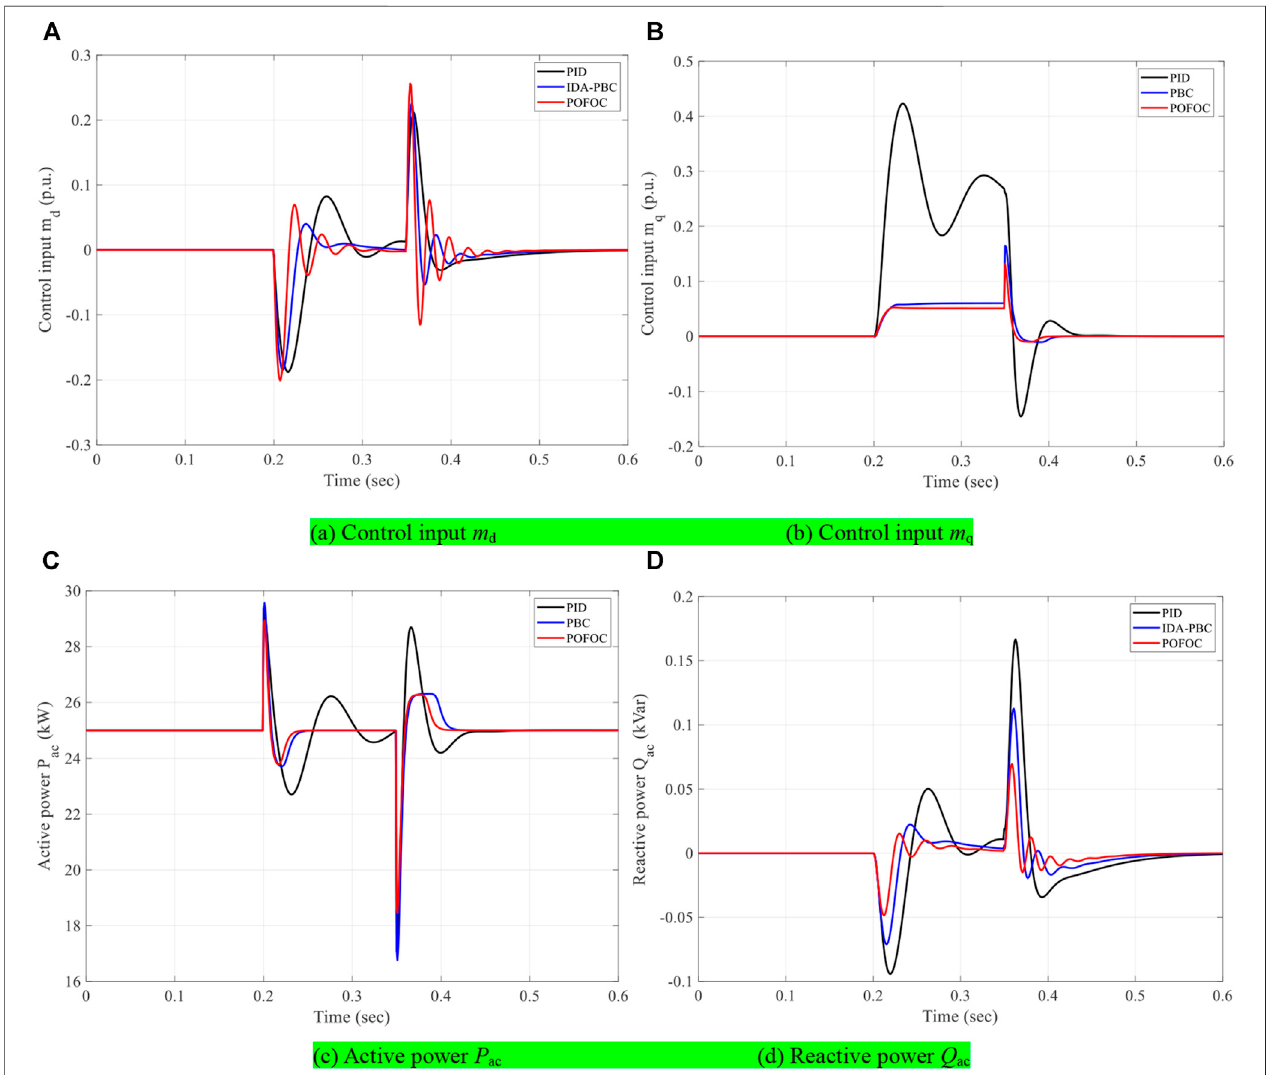
FIGURE 9 | System responses under power system fault. (A) Control input m d . (B) Control input m q . (C) Active power P ac . (D) Reactive power Q ac .